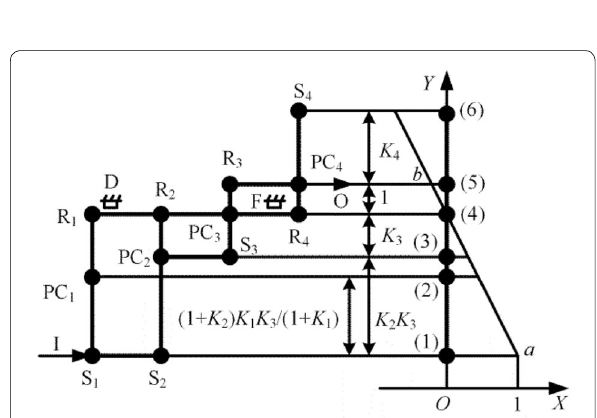
Figure 11 Equivalent lever speed diagram when D and F